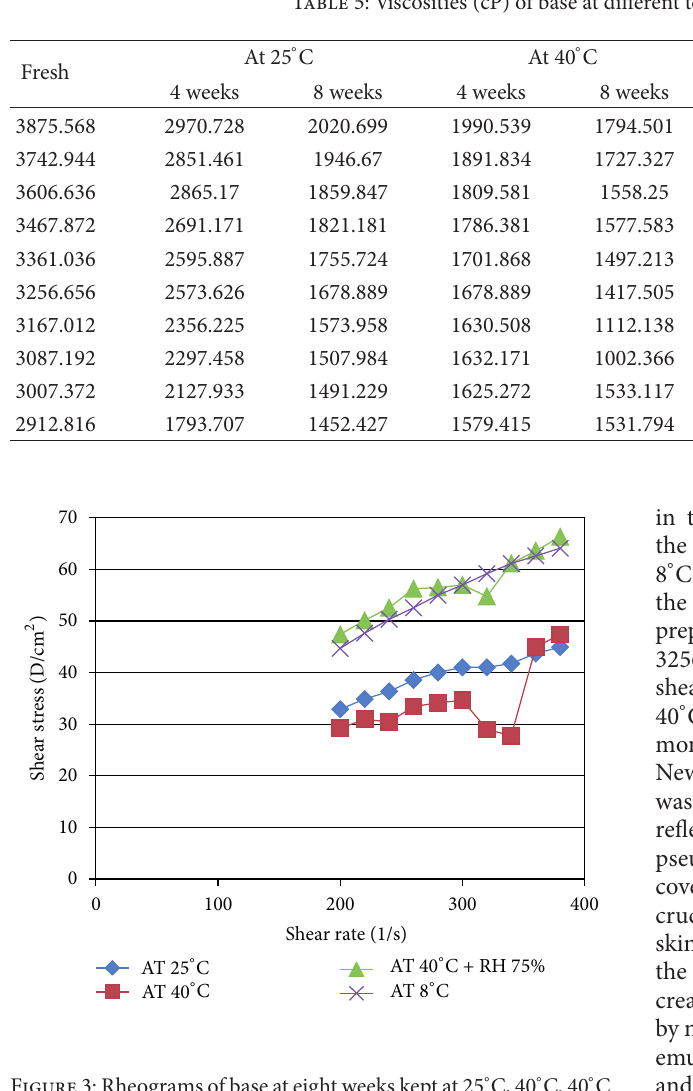
T 5: Viscosities (cP) of base at different temperatures and time